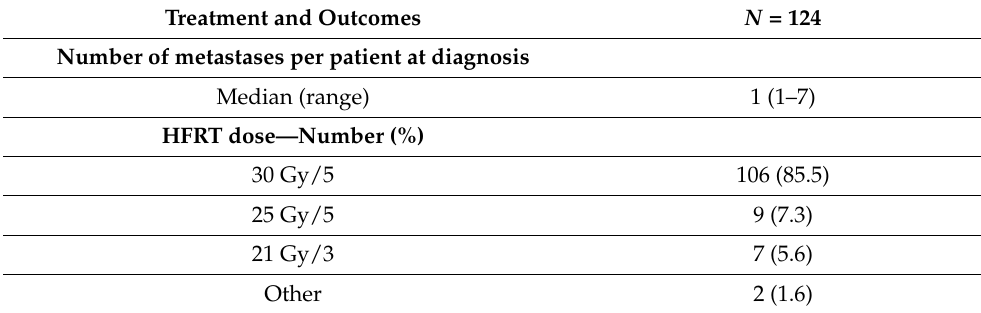
Table 2. Summary of treatments and volumetric outcomes of the 124 included patients. HFRT = hy- pofractionated radiotherapy, SRS = stereotactic radiosurgery, VMAT = volumetric modulated arc therapy, WBRT = whole-brain radiotherapy. *A negative value for volume reduction indicates volume